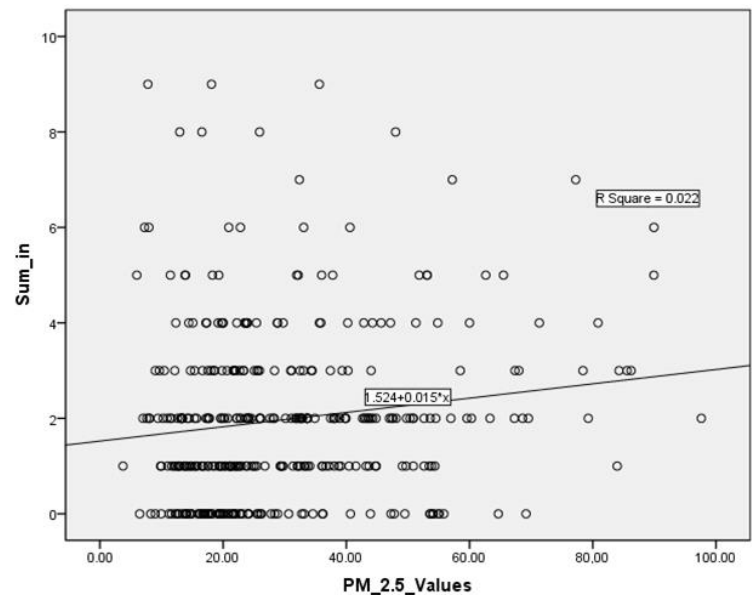
Figure 3. Correlation between daily PM2.5 levels and daily ED visits.